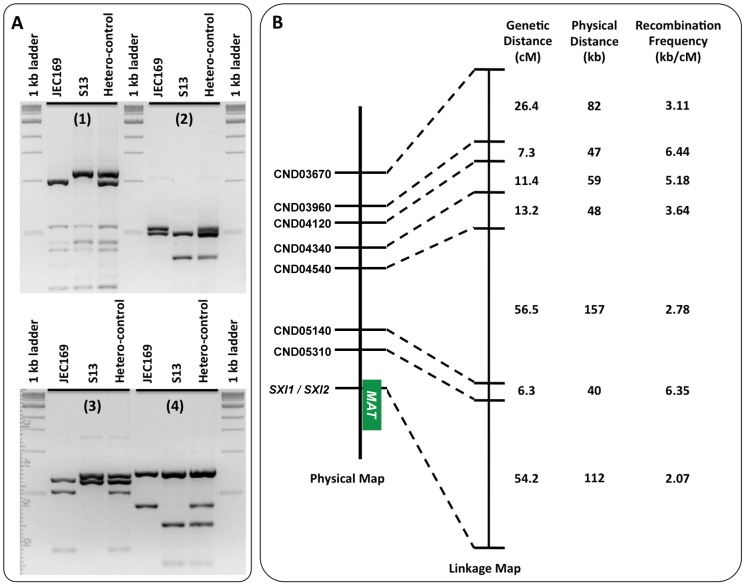
Meiotic recombination frequencies in chromosomal regions proximal to the MAT locus.(A) Examples of the co-dominant PCR-RFLP markers used to construct the genetic linkage map of the meiotic progeny shown in Figure 7B. Shown here are the gel separations of the restriction enzyme digestion products of markers CND05310 (A1), CND04540 (A2), CND03960 (A3), and CND04340 (A4). For each marker, from left to right, are the digestions of PCR products using genomic DNA of JEC169, S13, and a mixture of JEC169 and S13 (heterozygous control) as templates, respectively. (B) On the left is the physical map of the eight genetic markers on strain JEC20/JEC21 chromosome 4. The green block indicates the position of the MAT locus. In the middle is the genetic linkage map constructed using the PCR-RFLP data listed in Table 3 and Table S2. The three columns on the right list the genetic distances between adjacent markers, the physical distances between adjacent markers, and the corresponding recombination frequencies (high kb/cM value indicates low recombination frequency).